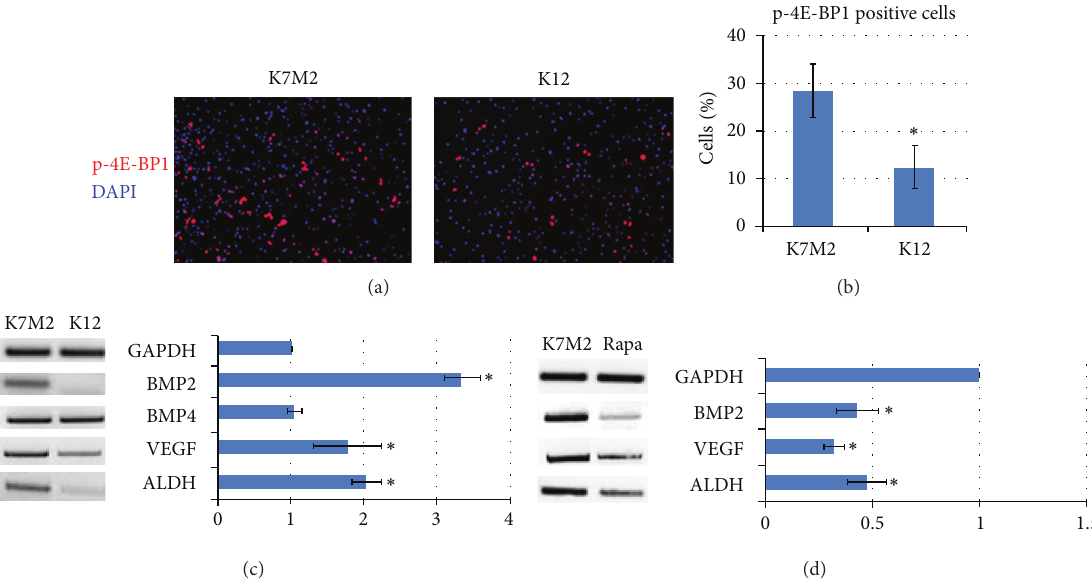
Figure 1: Phospho-4E-BP1 levels and rapamycin-sensitive gene expression in murine OS cells. (a) Immunofluorescence analysis of K7M2 and K12 cells depicting phospho-4E-BP1 (p-4E-BP1) counterstained with DAPI. (b) Quantitative analysis of p-4E-BP1 staining comparing the percentage of positive K7M2 and K12 cells. (c) RT-PCR was performed on cellular RNA extracted from K7M2 and K12 cells in order to quantitate the relative expression of BMP2, BMP4, VEGF, and ALDH-1A1. GAPDH serves as a loading control. (d) RT-PCR was performed on cellular RNA extracted from K7M2 cells treated with rapamycin or DMSO only (K7M2) in order to quantitate the relative expression of BMP2, VEGF, and ALDH-1A1 in the presence of mTORC1 kinase inhibition. Again, GAPDH serves as a loading control. Asterisks ( ∗ ) indicate statistically significant differences ( 𝑃 < 0.05